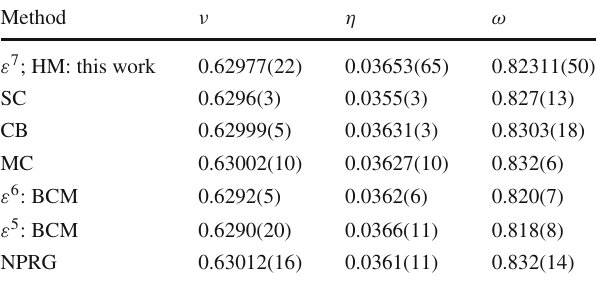
Table 2 The seven-loop ( ε -expansion) hypergeometric-Meijer resum- mation results ( ε 7 ;HM) for the exponents ν,η and ω of the Ising-like model ( N = 1 ) . The recent SC resummation results are listed for com- parison. Also we list conformal bootstrap calculations from Ref. [24] and Monte Carlo simulation (MC) from Ref. [12]. In this table also, we list the six-loop ( ε 6 ) resummation results from the Borel with con- formal mapping (BCM) from Ref. [32] and five-loops ( ε 5 ) from same reference. The recent results from the non-perturbative renormalization group (NPRG) method [28] is listed